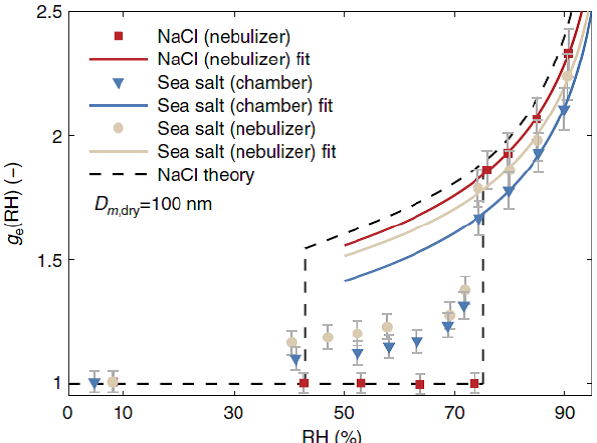
Figure 20. Measured hygroscopic growth factors of NaCl and syn- thetic sea salt aerosol particles as different RH. NaCl aerosol par- ticles were generated using a nebulizer, and both a nebulizer and a sea spray chamber were used to generate sea salt aerosol particles. Reprint with permission by Zieger et al.